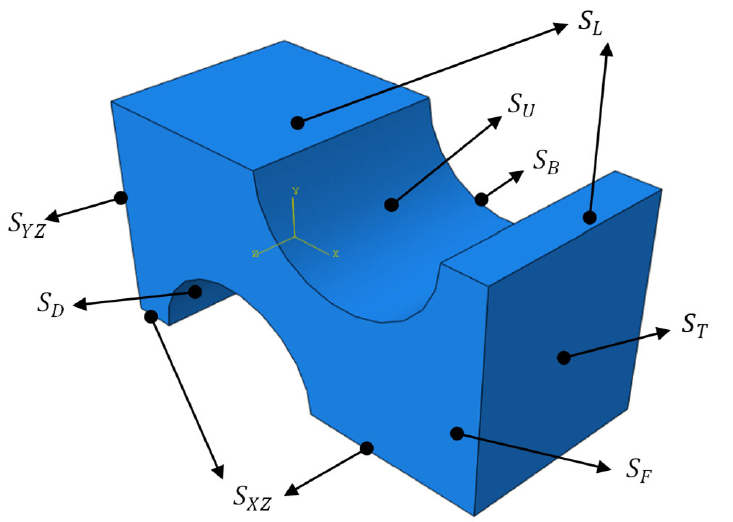
Figure 12. Loading surface and symmetry plane of the basic simulation unit In Figure 12, S U and S D are the punching surfaces. S F and S B are the front and behind surfaces. S YZ and S XZ are the symmetry planes of the model along the XZ